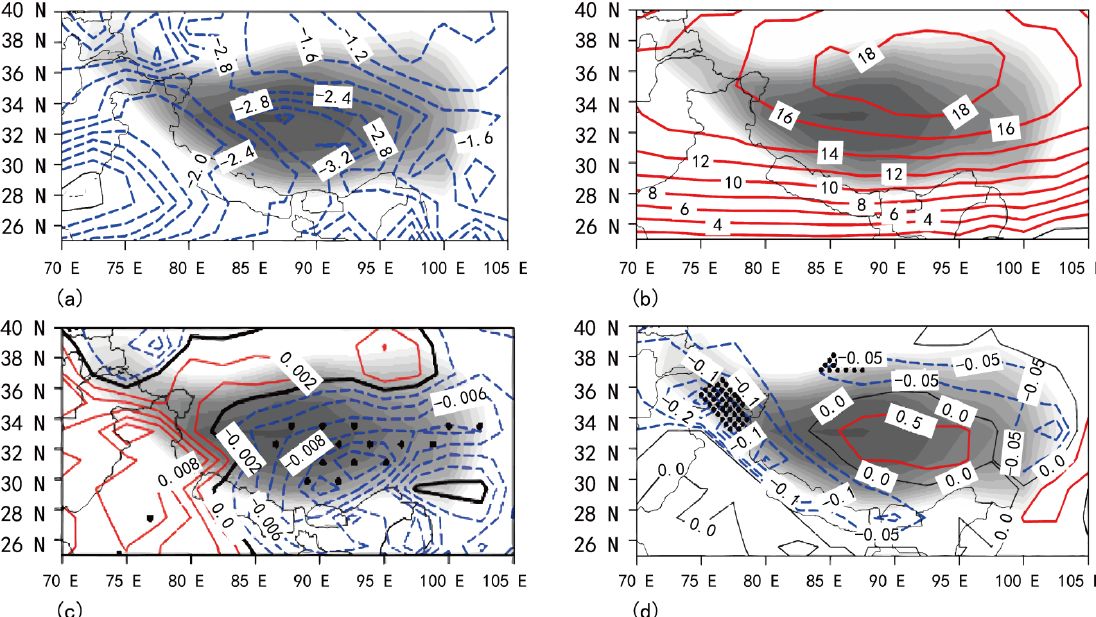
Figure 14. Spatial distribution of annual average differences between high and low TSI years of ( a ) geopotential height field at 500 hPa (unit: m), ( b ) geopotential height field at 100 hPa (unit: m), and ( c ) vertical velocity ω (unit: Pa/s), and ( d ) snowfall rate (unit: mm/d). Stippling indicates the grid points that passed the 0.05 significance test; shading indicates plateau areas. (The red line indicates the positive value, and the blue line indicates the negative value).